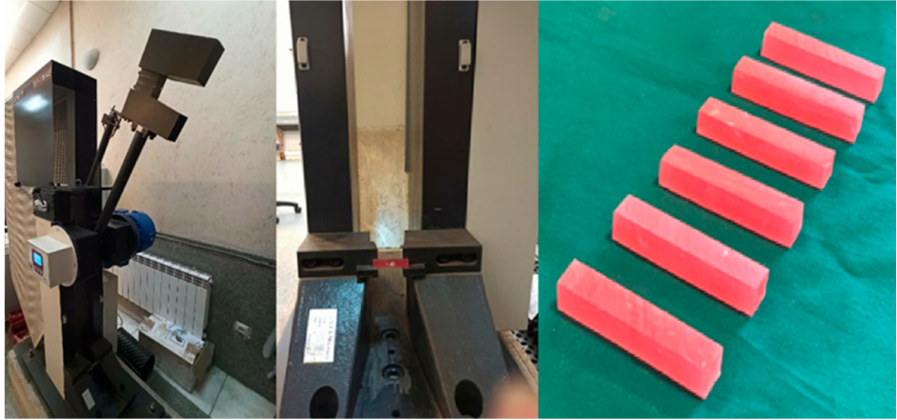
Figure 4. Pendulum Charpy impact testing machine and prepared